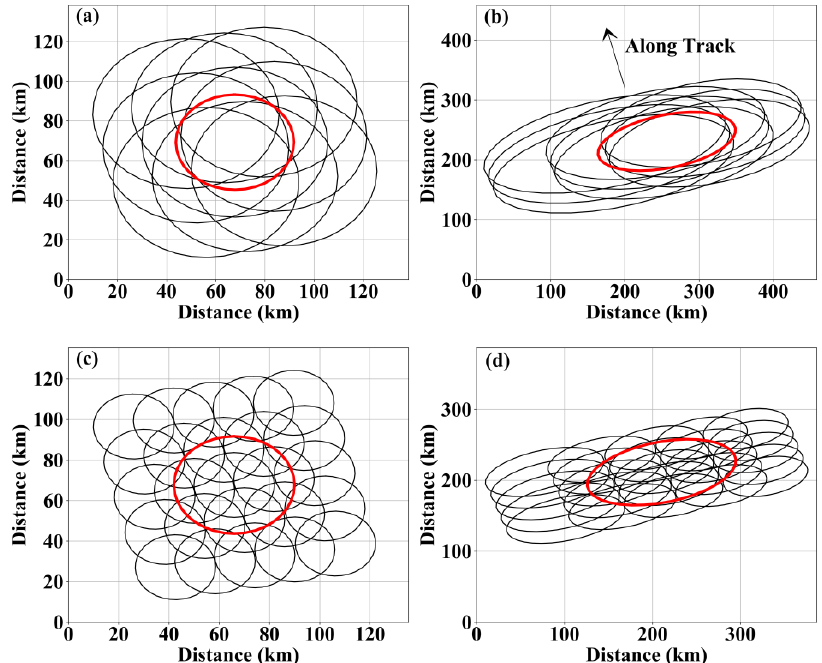
Figure 1. Advanced Technology Microwave Sounder (ATMS) original (black) and expected (red) 3-dB footprints on the earth’s surface. The top panels show the resolution enhancement from the ATMS channel-1 5.2 ◦ FOV to the AMSU-A-like 3.3 ◦ FOV at ( a ) nadir and at ( b ) the scan edge. The bottom panels show the resolution degradation from the ATMS channel-3 2.2 ◦ FOV to the AMSU-A-like 3.3 ◦ FOV at ( c ) nadir and at ( d ) the scan edge.